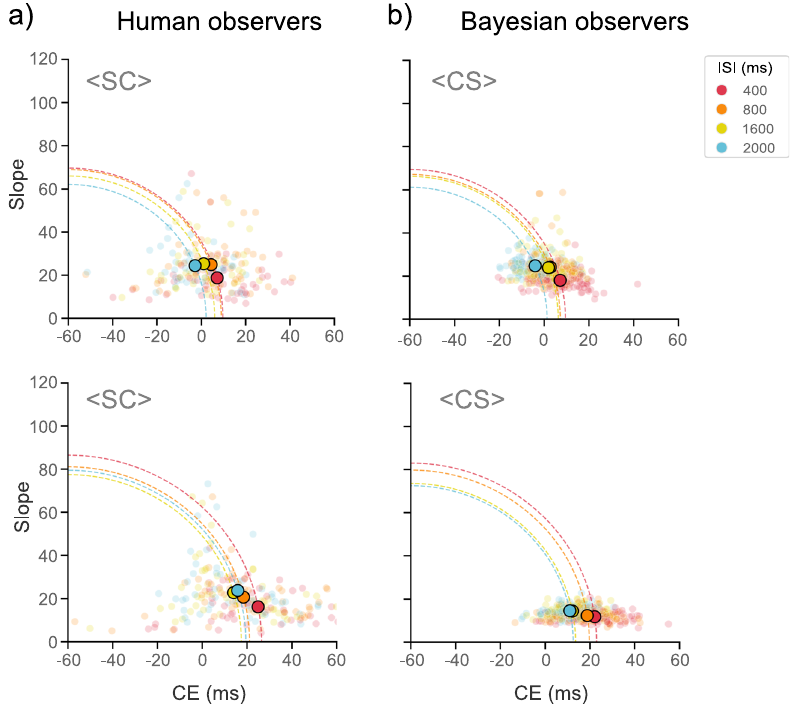
Figure 4. Root mean squared errors (RMSEs) of human and Bayesian observers. ( a ) RMSEs of human observers. RMSEs are given by the distance from the origin and are depicted by a quarter circle. Any increase in the CE or the slope will lead to a larger radius. Big dots depict the intersection of the CE and the slope’s mean for each group and each ISI level. Small dots depict individual CEs and slopes values. CE mean values decrease as a function of the ISI, with exception of the ISI 2000 condition of the <CS> group. However, CE mean values are higher for the <CS> than for the <SC> group. ( b ) RMSEs of Bayesian observers. Bayesian observer’